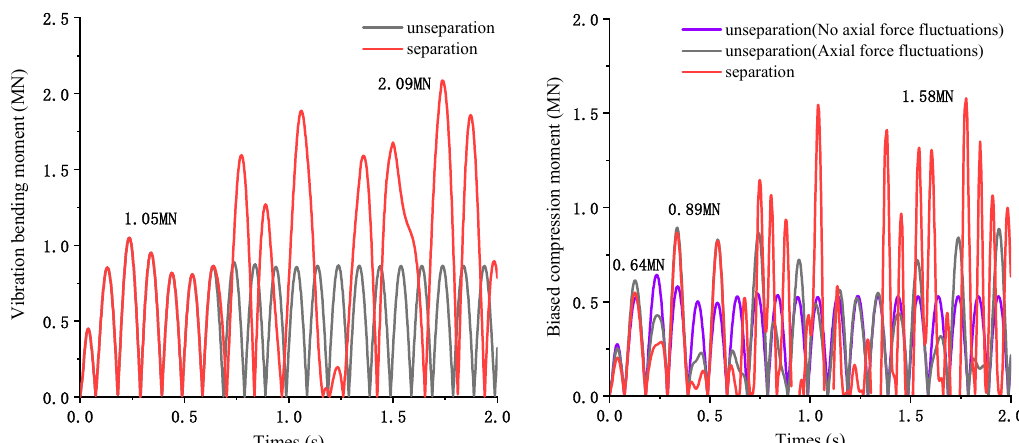
12 of 21 Figure 5. Longitudinal relative displacement of pier beam under different pier height: ( a ) Longitu- dinal relative displacement of pier beam under two conditions of separation or not when H = 9 m;